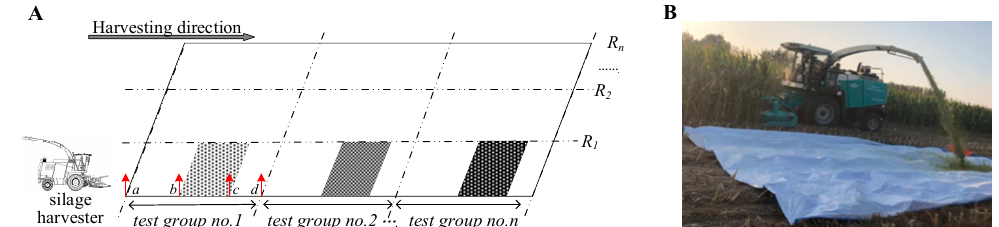
Figure 5. The experiment process of harvesting in the field(where R 1 , R 2 , …, and R n are harvesting crop rows); ( A ) Grouping schematic; ( B ) Picture of the field test. crop rows); ( A ) Grouping schematic; ( B ) Picture of the field